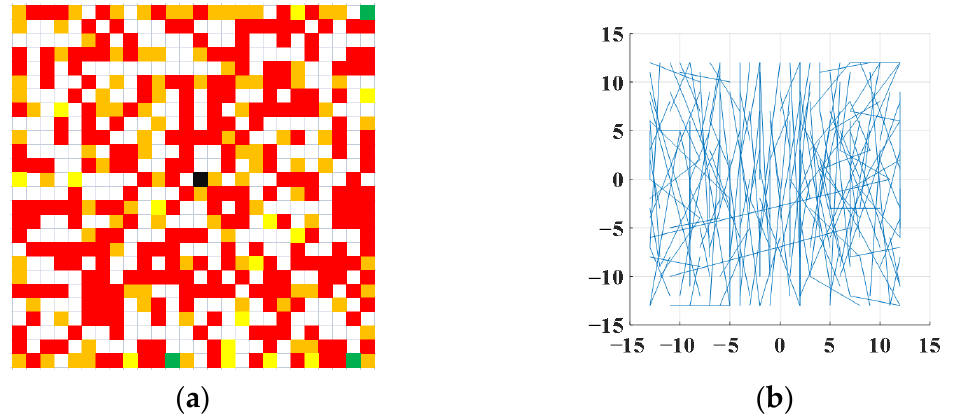
Figure 3. The selected number and position of rBrief pixels. ( a ) Number of pixel pair selection; ( b ) The position of the pixel pair selection.